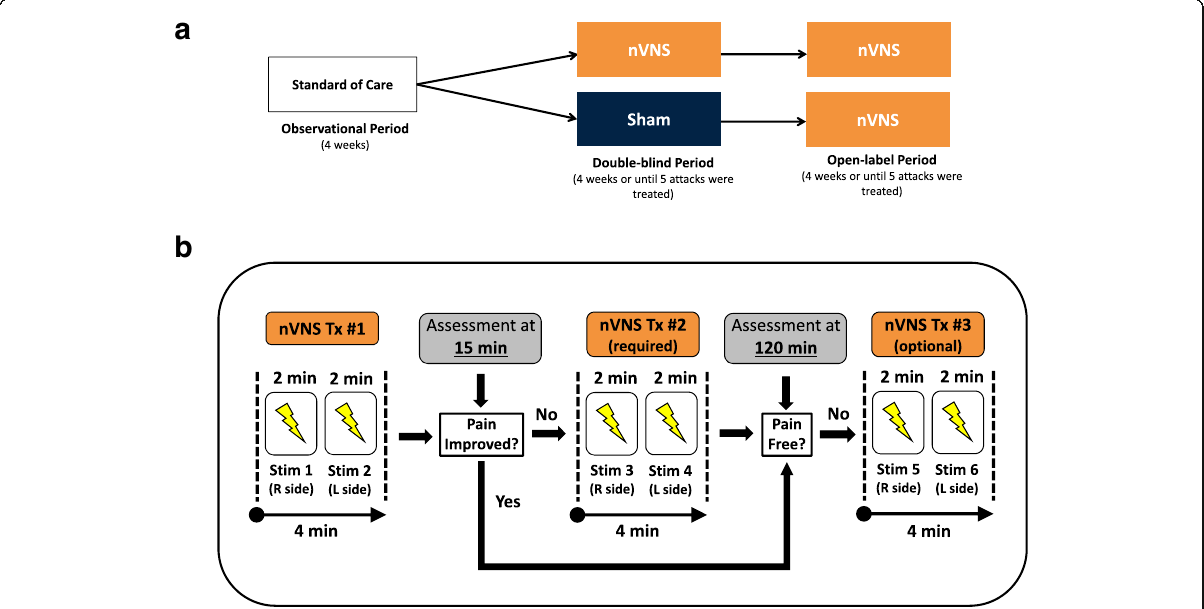
Fig. 1 PRESTO study design ( a ) and treatment protocol ( b ). Abbreviations: L, left; nVNS, non-invasive vagus nerve stimulation; R, right; Stim, stimulation; Tx,